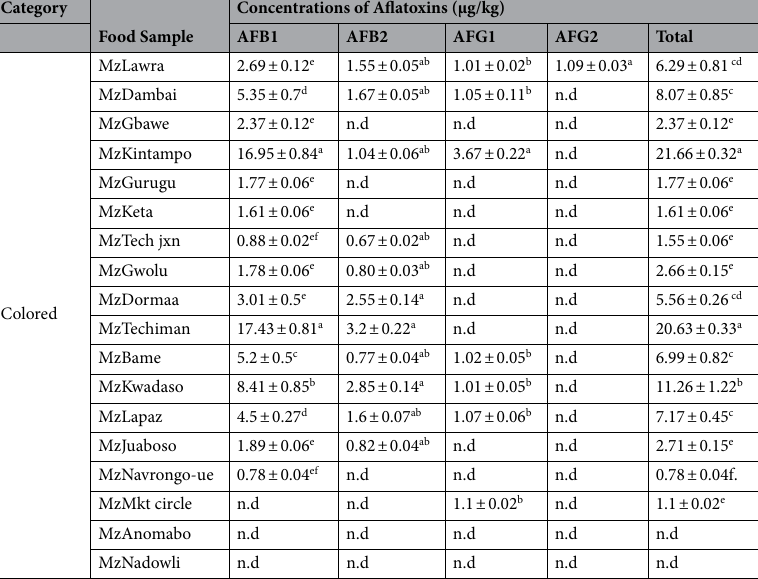
Table 7. Concentration of aflatoxin types in different maize samples from different locations of Ghana. Mean ± Standard Deviation that do not share a letter are significantly different (p > 0.05). n.d not detected.